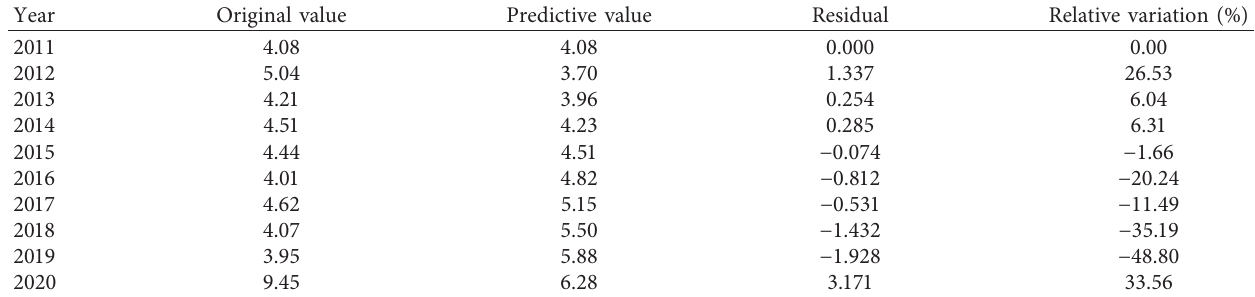
Table 6: Grey system prediction and verification of primary industry market share in China from 2011 to 2020.